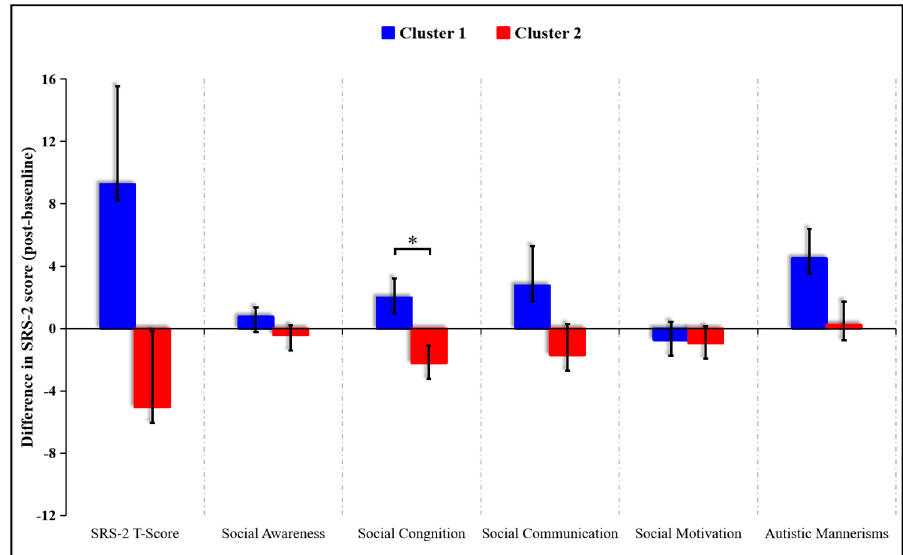
Figure 3. Illustrations of K-means cluster analyses (cluster 2 showed significantly lower scores on the social cognition subscale of the SRS-2 compared to cluster 1. * p < 0.05).